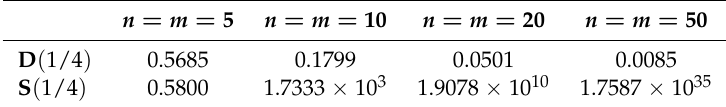
Table 1. A small change in the data result in a large change in the